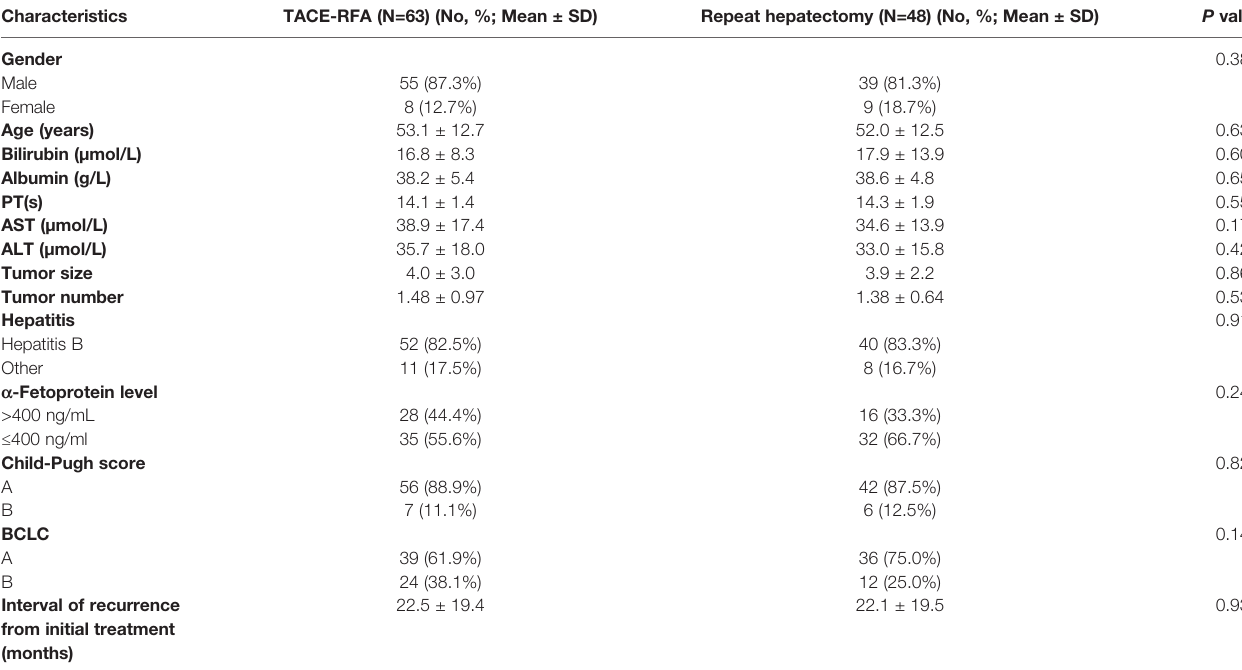
TABLE 1 | Baseline characteristics.